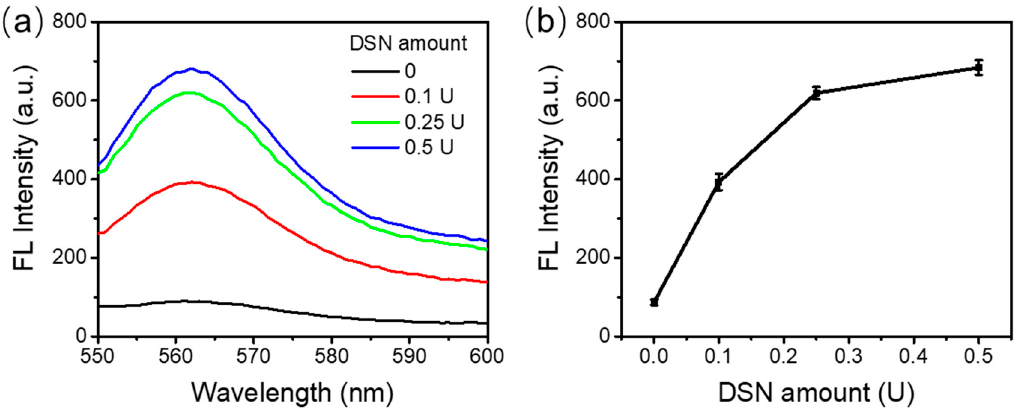
Figure 3. DSN enzyme activity. ( a ) Fluorescence emission spectra with various amounts of DSN enzyme. ( b ) The peak fluorescence values with different amounts of DSN enzyme.